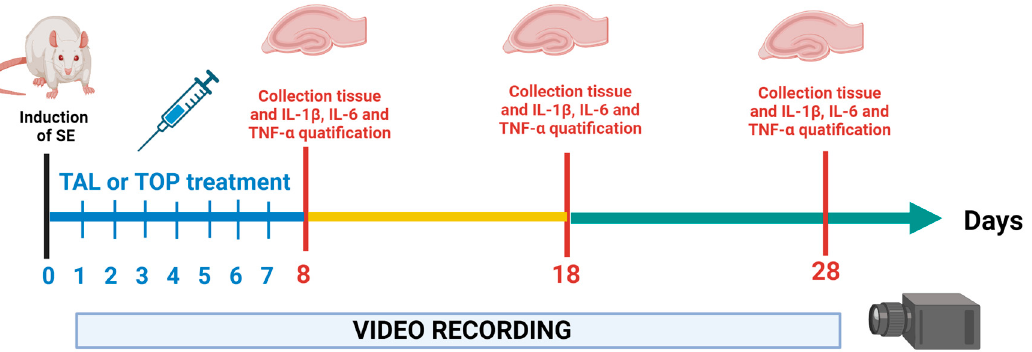
Figure 5. Experimental design. At time 0, status epilepticus (SE) was induced in male Sprague-Dawley rats via administration of lithium-pilocarpine. One day after SE induction rats received daily pharmacological treatment with topiramate (TOP) or thalidomide (TAL) for seven days. One day after treatment the first determination was performed (evaluation time 8). The animals were sacrificed, and hippocampus were collected to determine the concentrations of interleukin IL-1 β , IL-6 and necrosis tumoral factor- α (TNF- α ) at three different evaluation times: 8, 18 and 28 post-SE days respectively. From 1 to 28 days post-SE, rats were video monitored during 24 h/7 days to observe the latency to the first spontaneous recurrent seizure (SRS) as well as, SRS number and